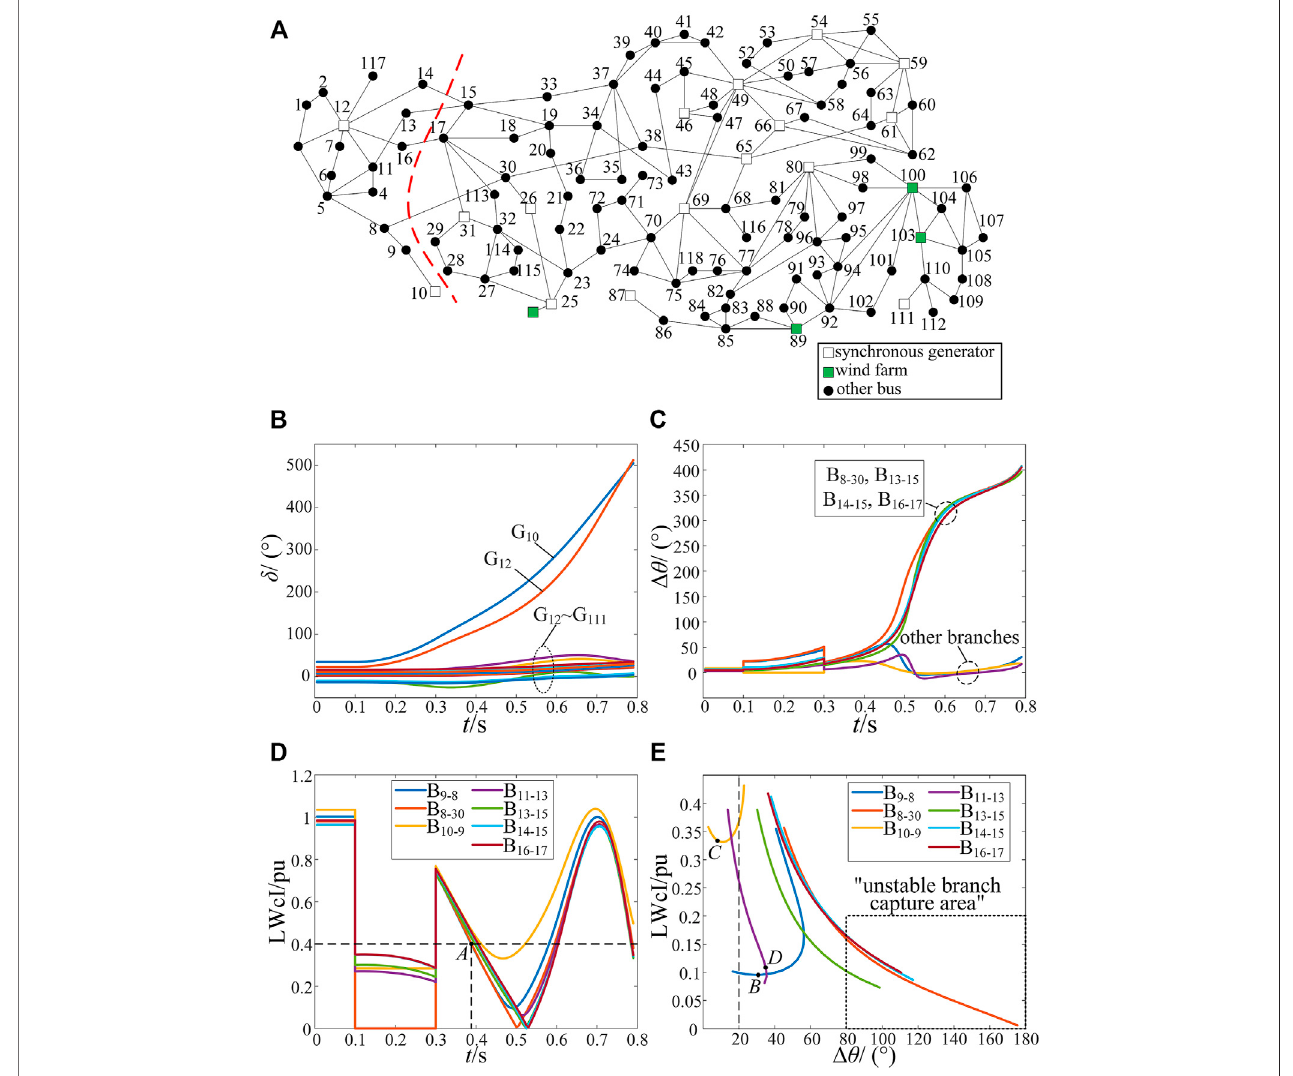
FIGURE 4 | The transient response of the IEEE-118 wind power system (A) is the diagram of IEEE-118 system with wind farms (B) is power angle curves of generators (C) is the voltage phase angle difference of branches (D) is the LWcI- t curve of different branches (E) is the LWcI- Δ θ curve of different branches during the period of 0.39 and 0.51